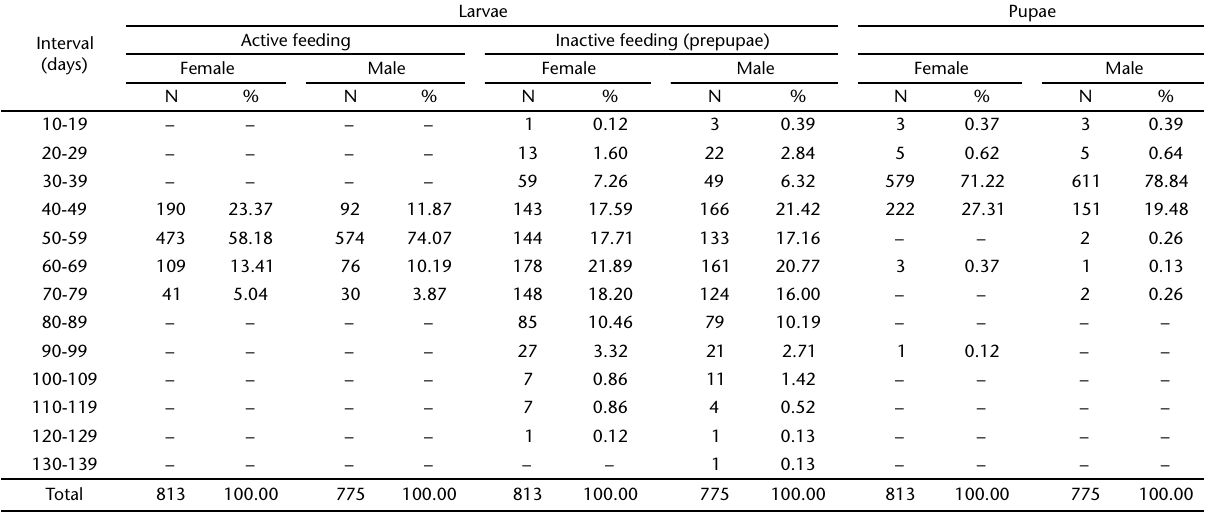
Table IV. Number of immature females and males of Agrotis malefida , at ten day intervals, indicating larval feeding activity, pre-pupae and pupae, maintained under controlled conditions (25 ± 1°C, 70 ± 10% RH and 14 hours photo phase). Interval (days)